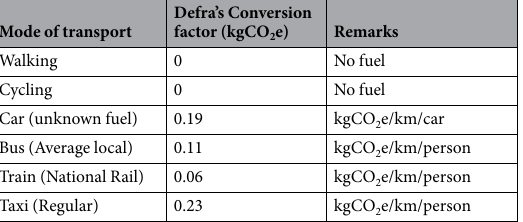
Table 2. Defra’s GHG emission conversion factors 2012. Note: The distance travelled by participants was measured in miles but converted to kilometres (1 mile = 1.61 km). The emission per spectator was calculated by multiplying distance travelled to and from games by appropriate conversion factor based on mode of travel and reported in kgCO